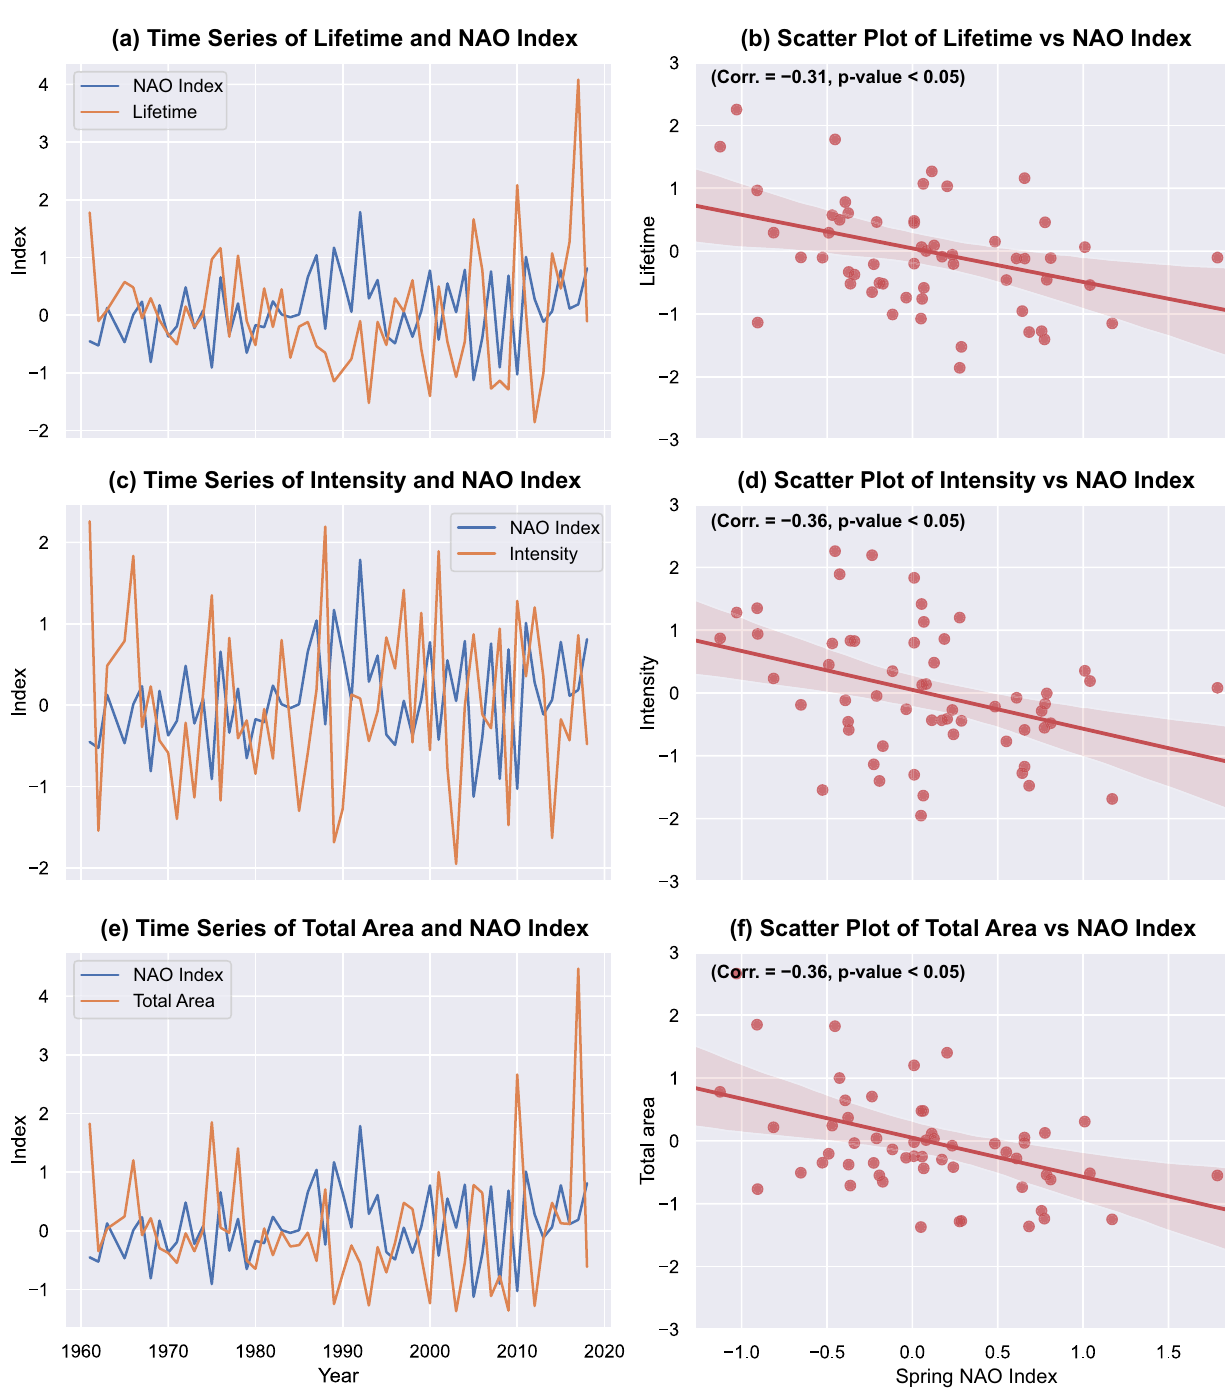
Fig. 8 Relationship between Type 2 contiguous heatwave metrics and the spring NAO index. a , c , e Time series of the lifetime ( a ), intensity ( c ), and total area ( e ) of Type 2 contiguous heatwaves and the spring NAO index. b , d , f Scatter plots of the lifetime ( b ), intensity ( d ), and total area ( f ) of contiguous heatwaves versus the winter Niño3.4 index, with the straight line indicating the corresponding fi tted line by simple linear